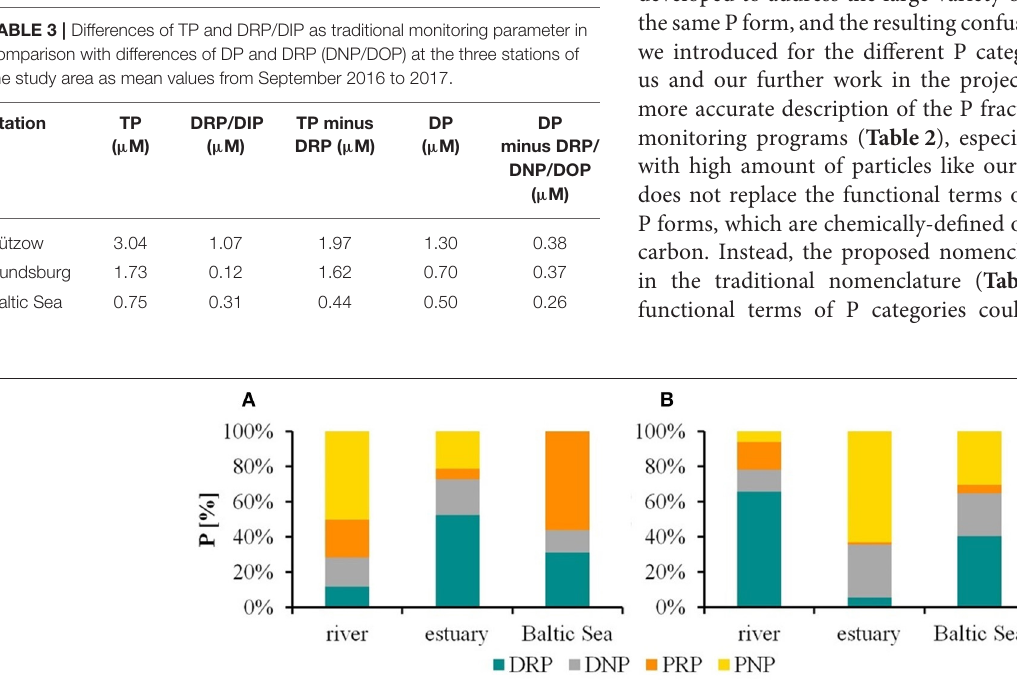
FIGURE 3 | Proportions (%) of the phosphorus (P) categories as a function of total P at the three study sites (Warnow River “Bützow,” its estuary “Hundsburg,” and the southern Baltic Sea “Baltic Sea”) during two different seasons: (A) February 2017, (B) = June 2017. DRP, dissolved molybdate-reactive P; DNP, dissolved non-molybdate-reactive P; PRP, particulate molybdate-reactive P; PNP, particulate non-molybdate-reactive P.